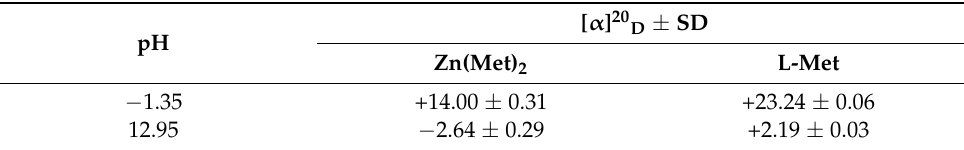
Table 1. Specific rotation of water solutions of Zn(Met) 2 and L-Met at different pH, w / v concentration 2% (134 mmol/L).